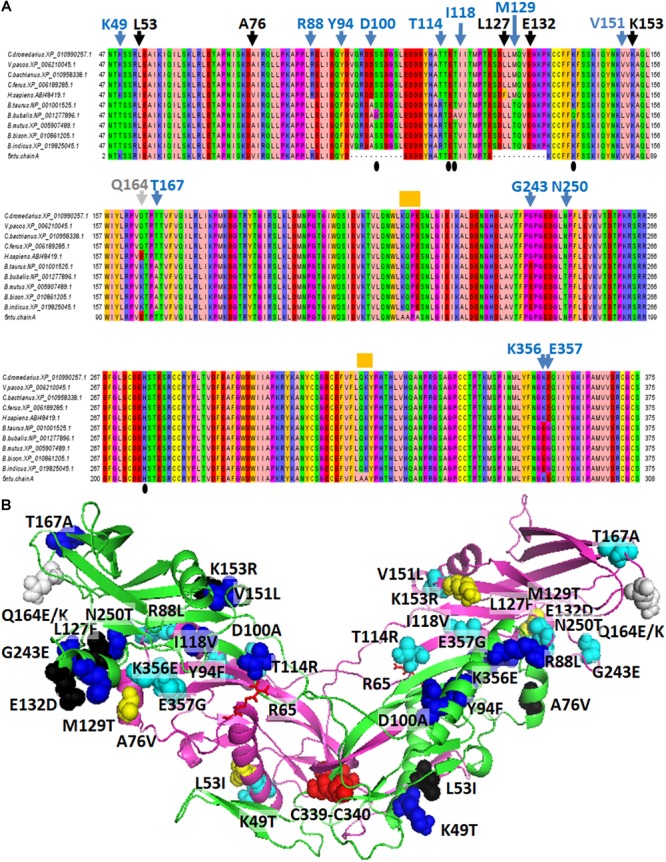
Comparative analysis of myostatin protein sequences. (A) The alignment of myostatin orthologous sequences sampled from various mammalian species is presented. Blue arrowheads indicate the variants detected between the four considered Camelidae sequences and the five Bovidae sequences at 13 specific sites. Black arrowheads indicate the variants detected between the four considered Camelidae sequences and the Homo sapiens sequence at 5 specific sites, different from the sites previously cited. The gray arrowhead indicates the position of two different variants detected in H. sapiens and in Bovidae in correspondence of Q164 from C. dromedarius. Orange “boxes” indicate variations between the H. sapiens sequence retrieved from refseq_database and the sequence of the human crystallized myostatin. Amino acid codes and numbering refers to the C. dromedarius myostatin. (B) Lateral view of the 3D comparative model of the C. dromedarius myostatin dimer. The protein is reported in green/magenta cartoon representation. Variants observed between Camelidae myostatin sequences and human/Bovidae myostatin are reported in black (5)/blue (13) spheres in chain A, and dark-yellow (5)/cyan (13) spheres in chain B, respectively. The only site of C. dromedarius myostatin showing a variation both in H. sapiens and in Bovidae locates at site 164 (Q164 for C. dromedarius, E164 in H. sapiens, K164 in B. taurus) and is indicated by gray spheres. Notably, variants observed between C. dromedarius and Bovidae occur at different sites with respect to those detected between C. dromedarius and H. sapiens, with the exclusion of residues at site 164. Residues C339/C340 of chain A and chain B, forming inter-monomer disulphide bridges, are reported in red spheres. R65 of chain A and chain B, involved in interactions with T114, is indicated by red sticks.